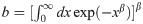
The probability SQ(r) that in a text the return intervals between words with rank above Q (see Fig 1) exceed a certain length r.We consider Q values where the mean return intervals have lengths RQ = 64, 32, 16, 8, 4, and 2 (from top to bottom). By definition, SQ(0) = 1. For transparency, we have multiplied SQ for RQ = 32, 16, 8, 4, and 2 by 10−2, 10−4, 10−6, 10−8, and 10−10, respectively, and plotted SQ as a function of r/RQ. The dots are the numerical results. The gray lines are the best fit to S = exp[−b(r/RQ)β], with b=[∫0∞dxexp(-xβ)]β for RQ ≥ 16 (see SI). The value of β is shown for each fit with its error bar as the standard deviation of the fit. The figure shows that for all texts and RQ above 2, stretched exponentials (where β < 1) make a remarkable fit. In each text, approximately the same exponent β characterizes SQ for RQ ≥ 16. The exponent varies only slightly in the different texts: Means and standard deviations were 1.1 and 0.13 for RQ = 2, 0.86 and 0.067 for RQ = 4, 0.85 and 0.059 for RQ = 8, 0.77 and 0.037 for RQ = 16, 0.76 and 0.037 for RQ = 32, 0.77 and 0.048 for RQ = 64. The dashed straight lines are for the shuffled texts. For 20 shuffled texts of Les Miserables, the means were 1.0 for all RQs, with standard deviations of 0.0052, 0.013, 0.0080, 0.012, 0.010, 0.028, for RQ = 2, 4, 8, 16, 32, and 64, respectively.